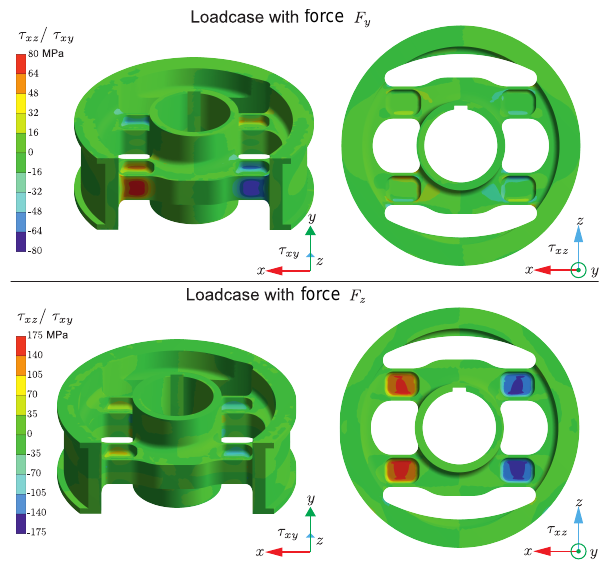
Figure 6. Finite element analysis of the deformation element with the forces F y and F z .